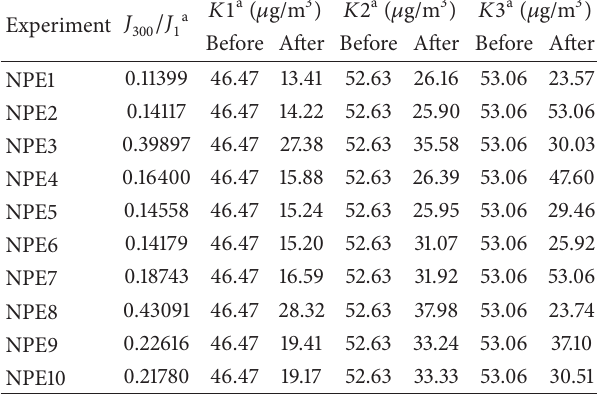
Table 4: Error statistics of NPEs before and after